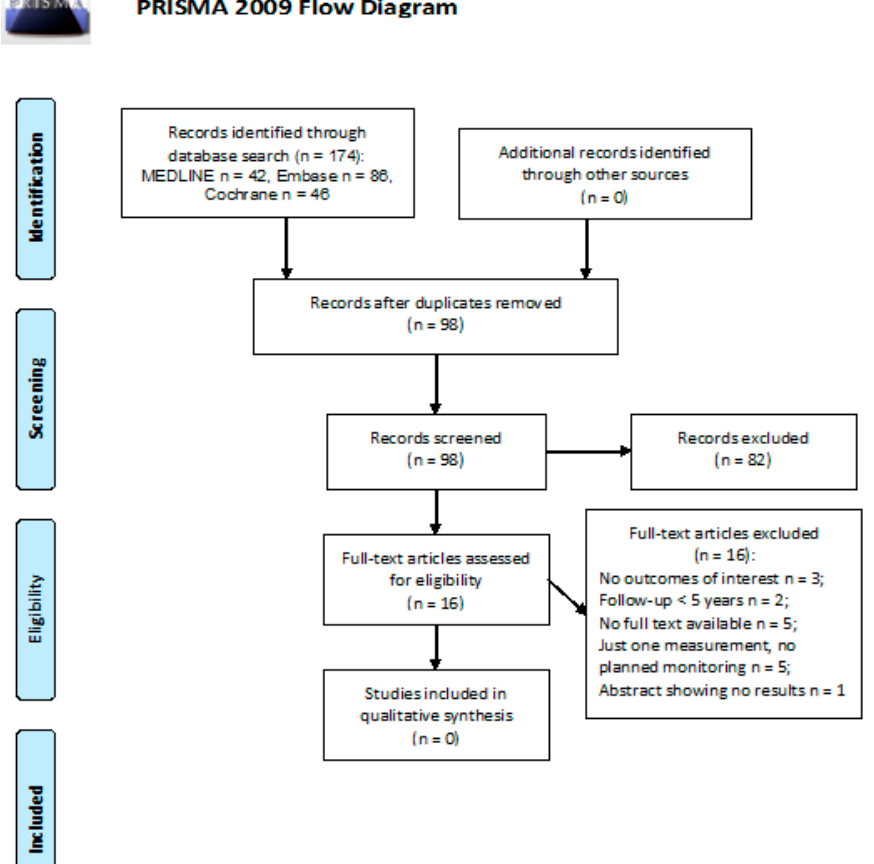
Figure 7. PRISMA flow diagram on the efficacy of follow-up programs for the diagnosis and management of anxiety and depression.